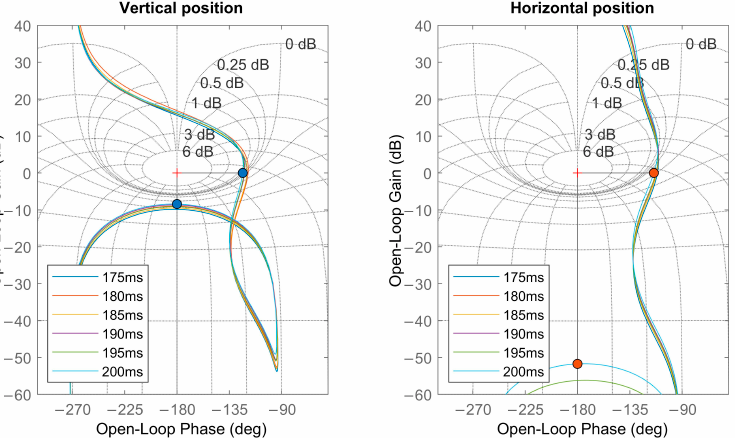
Figure 4. Set of Nichols diagrams of an open-loop system with plasma models corresponding to different moments in time with PID-controllers tuned with QFT.